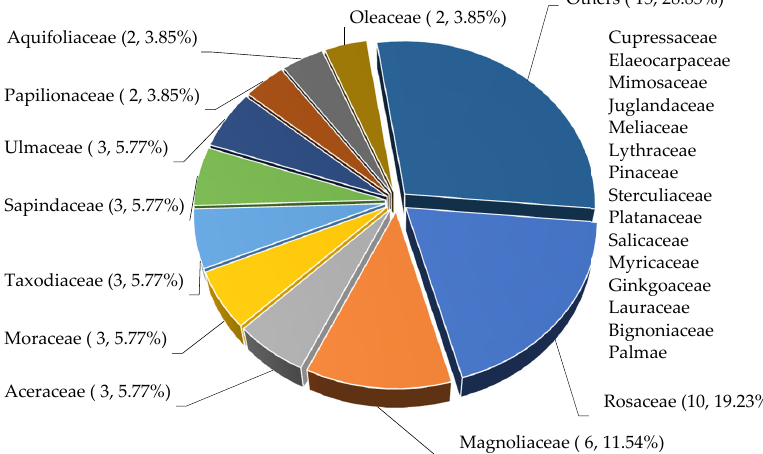
Figure 3. Distribution of the tree species by botanical families in the resettlement residential areas of Changzhou. The numbers in brackets denote the number of species and the respective percentage of species out of the total number of species in each family.